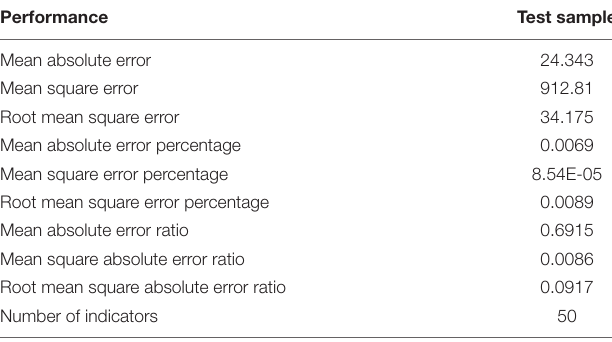
TABLE 3 | SVM model performance evaluation form.